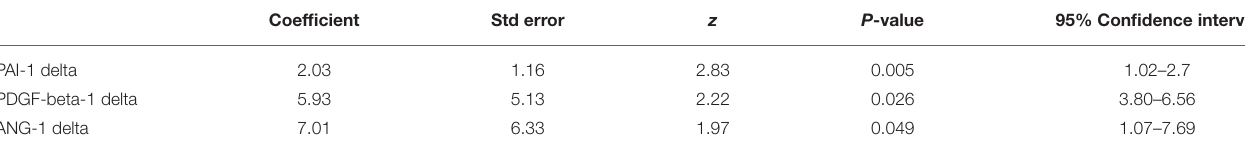
TABLE 7 | Average treatment effect (defined as difference between first time point and second timepoint) based on propensity score matching ( n =